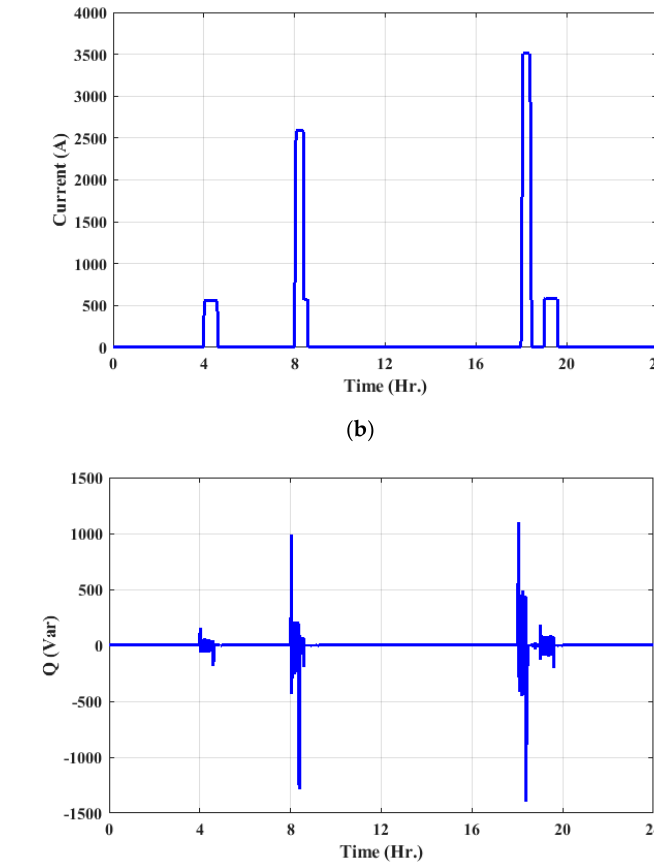
Figure 17. Parameters of EV: ( a ) voltage, ( b ) current, ( c ) active power, and ( d ) reactive power.